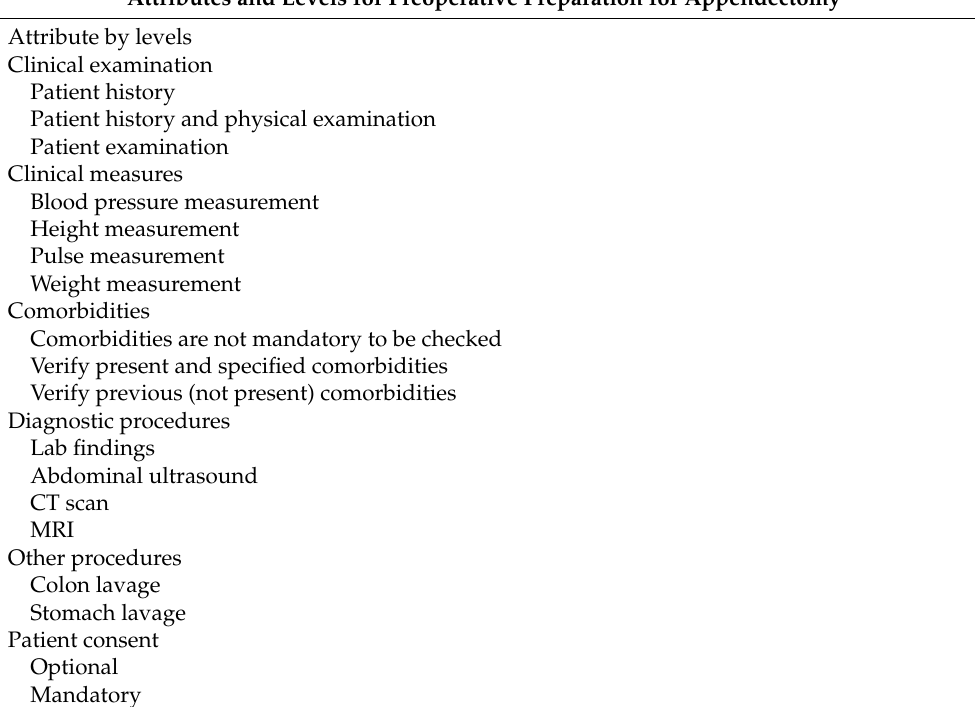
Table 2. Attributes and levels for preoperative preparation for